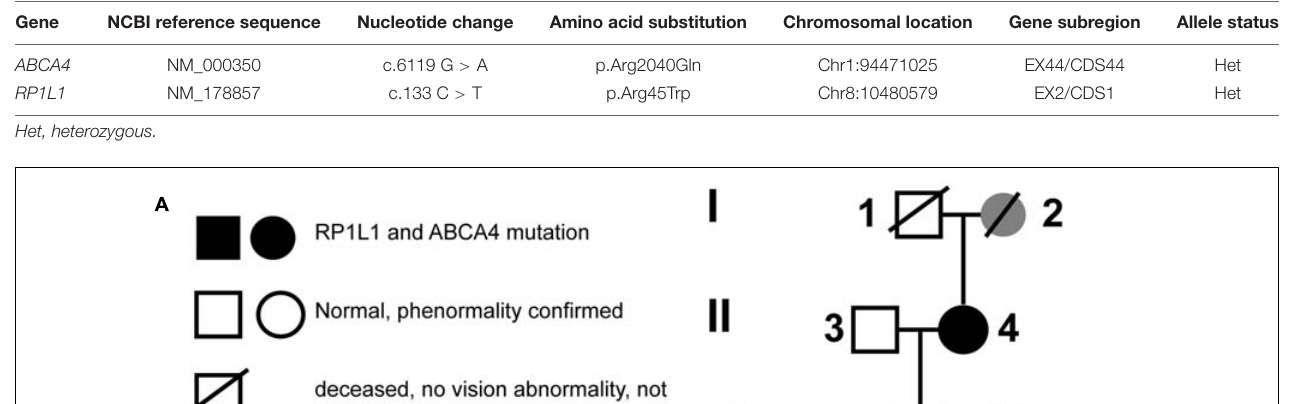
TABLE 2 | Mutations identified in the present study.